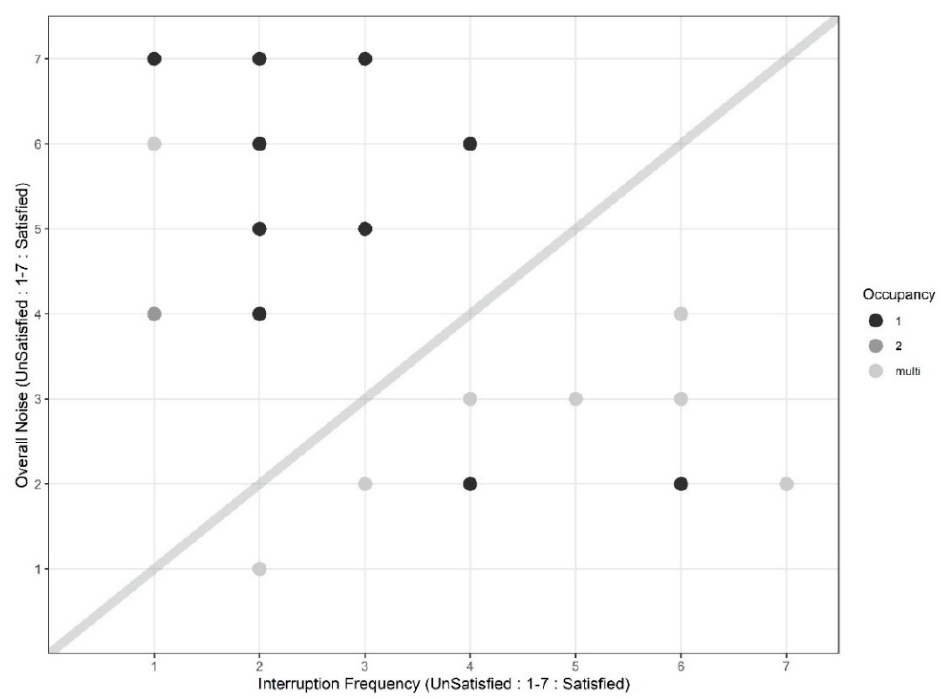
Figure 4. Scatterplot of the Overall Noise satisfaction and satisfaction with Interruption Frequency grouped by different room occupancy (1: single office; 2: twin office; multi: open plan multi occupancy).